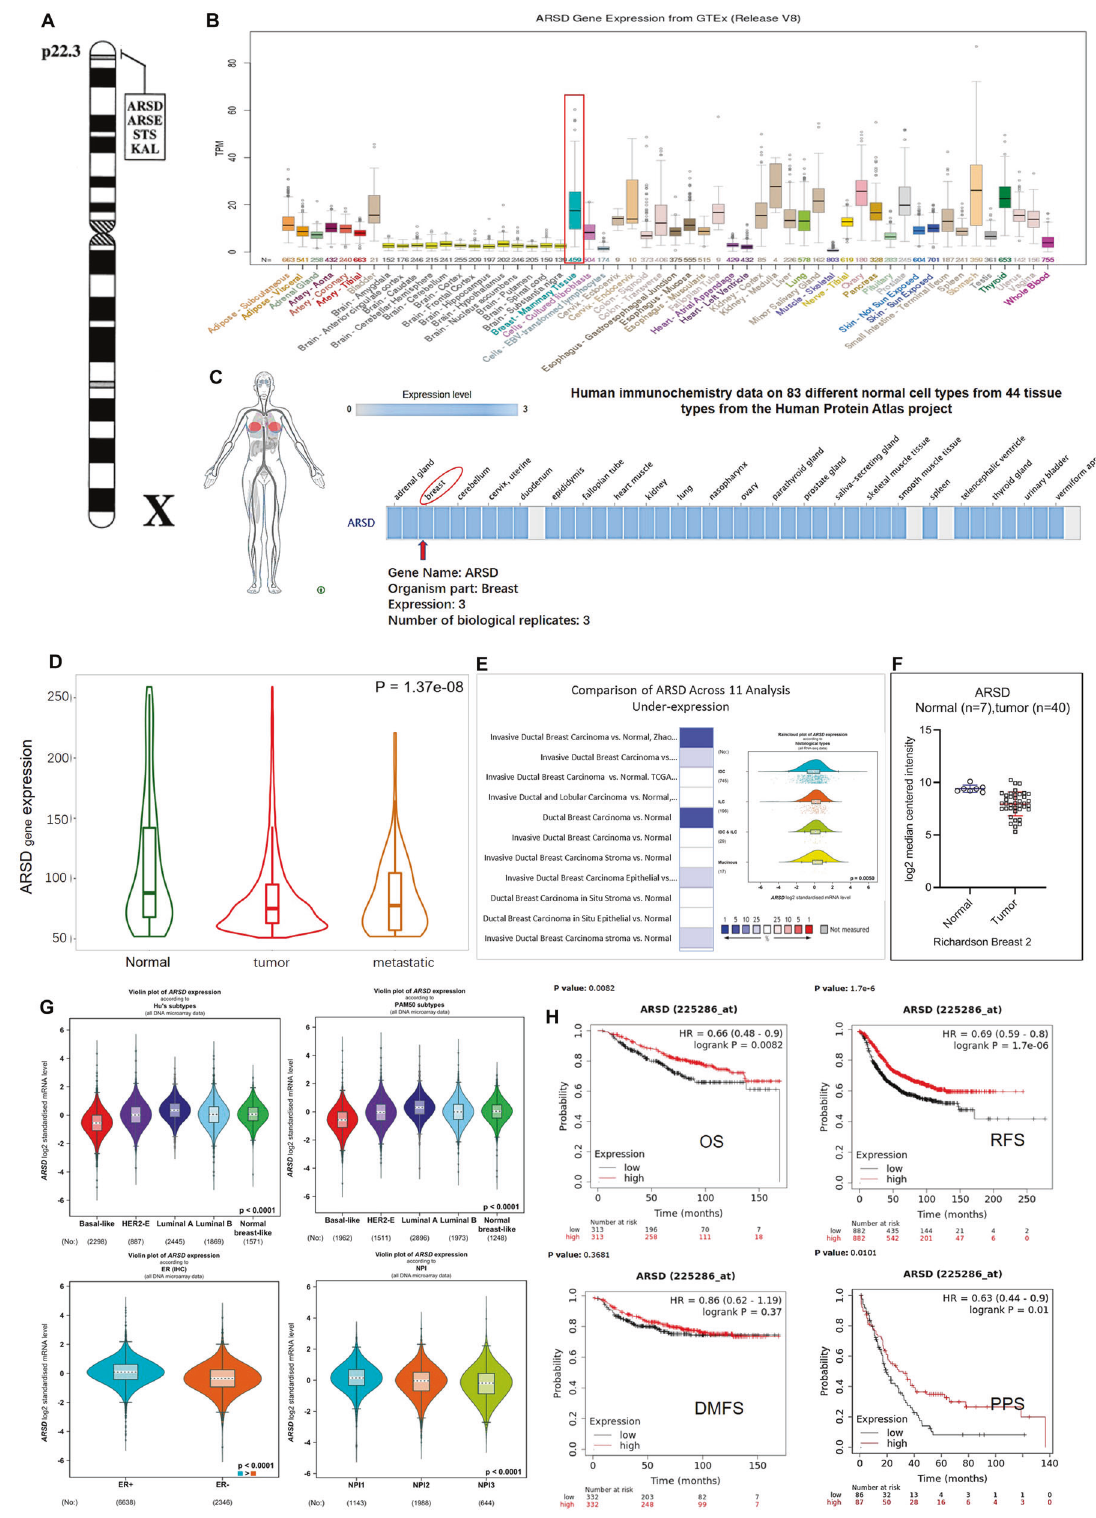
tissue relative to other tissues. Meanwhile, a reduced ARSD expression level was observed in breast tumor tissues or metastatic breast tissues when compared with normal breast tissues ( p = 1.37e-08) (Fig. 1D). Oncomine database shows 26 low expressions of ARSD in 44 BC analyses (Supplementary Fig.